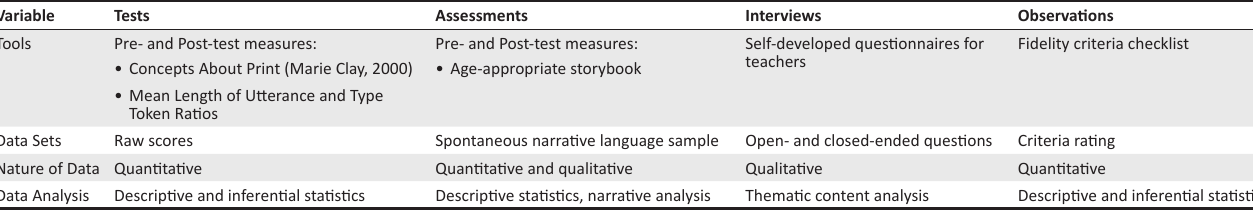
TABLE 1: Research